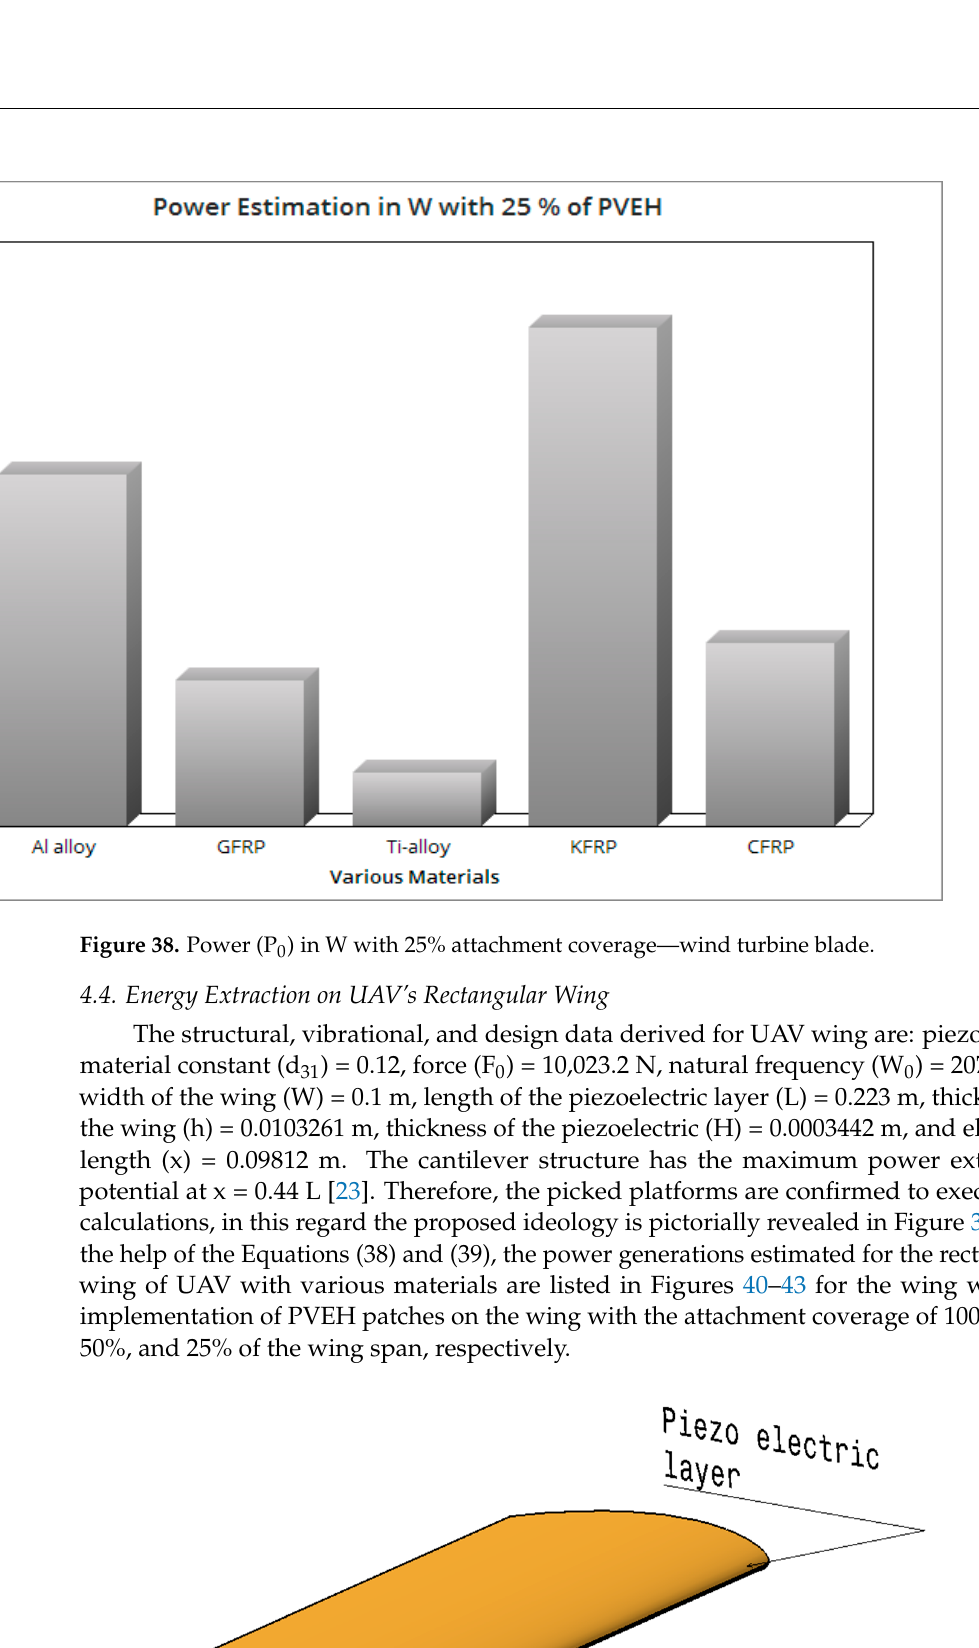
Figure 37. Power (P 0 ) in W with 50% attachment coverage—wind turbine blade.